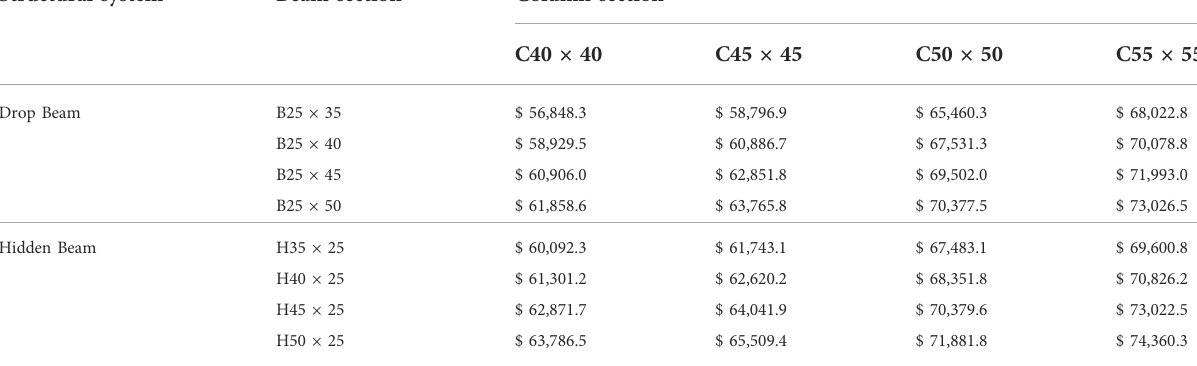
TABLE 9 Total costs for building structure. Structural